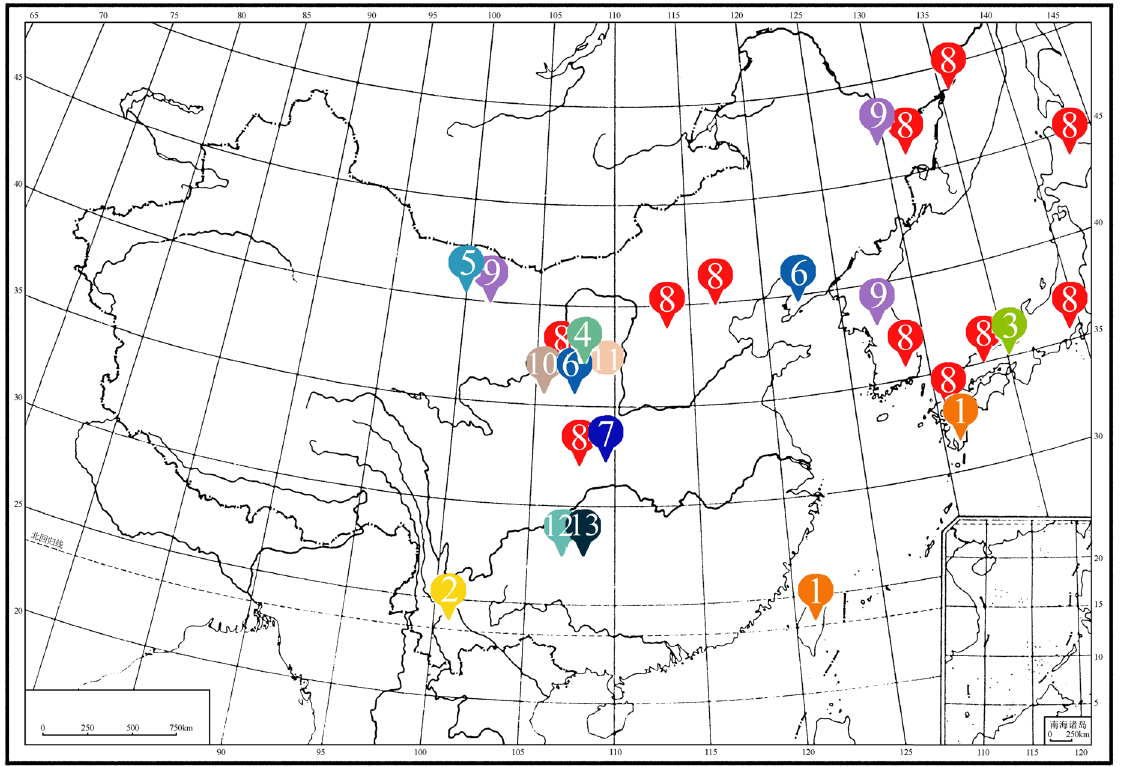
Fig. 7. Geographic distribution of species of Machaerotypus Uhler, 1896: 1 . M. arisanus (Kato,